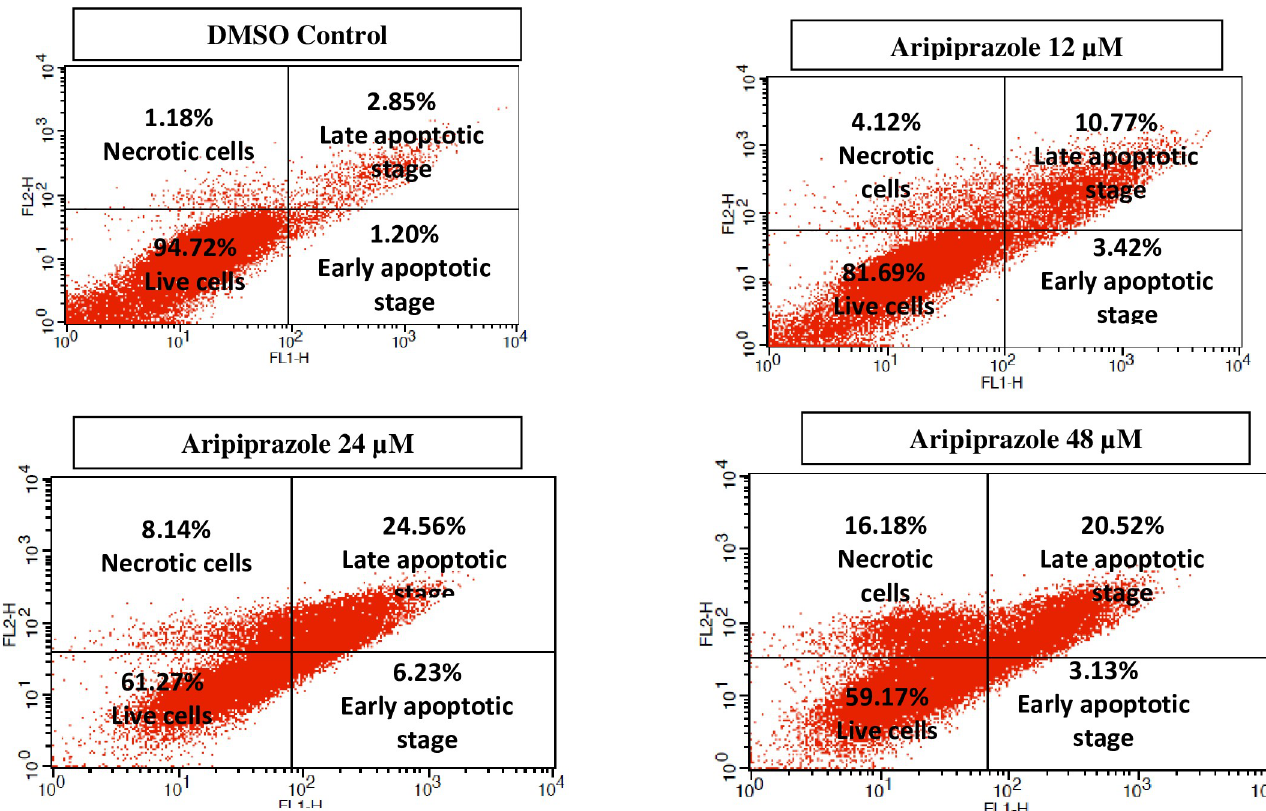
Fig 4. Dot plot representing the total cell count (%). The distribution of viable cells (lower left), dead cells (necrotic) (upper left), early apoptotic (lower right), and late apoptotic cells (upper right) in the four quadrants of dot plots of untreated, aripiprazole treated (12, 24, and 48 μ M) MCF-7 cell line. Total 10,000 cells in triplicate were analyzed during sample